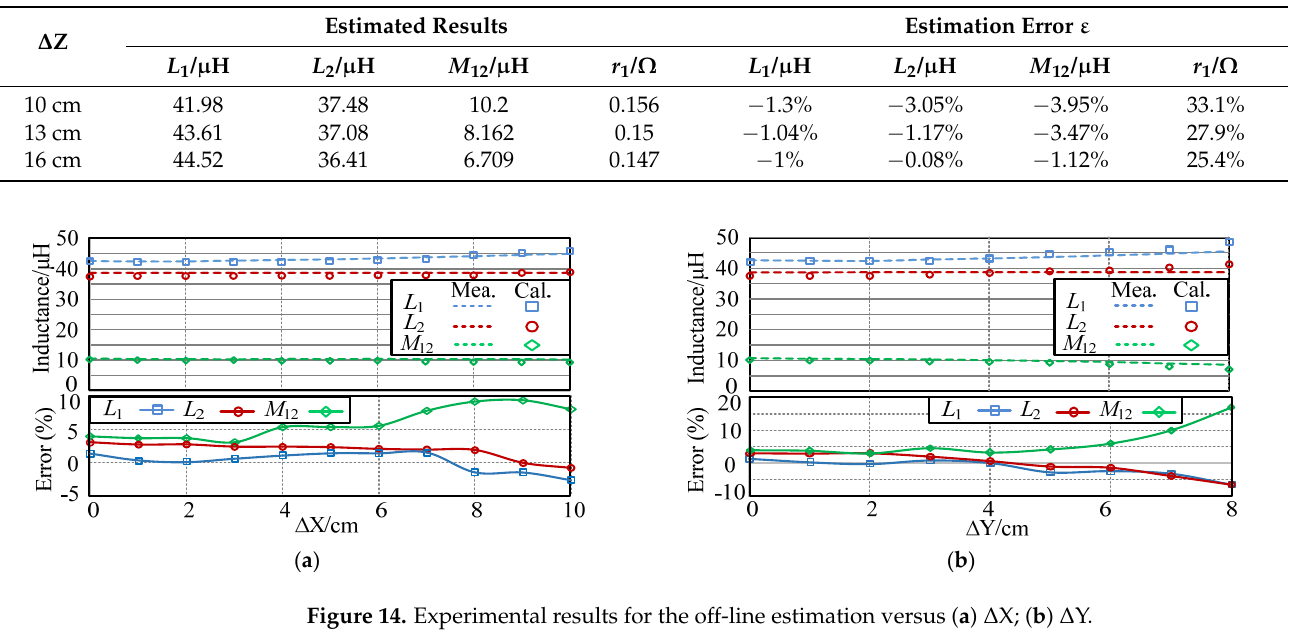
Table 4. Estimated results of M 12 , L 1 , L 2 , and r 1 at different clearances.